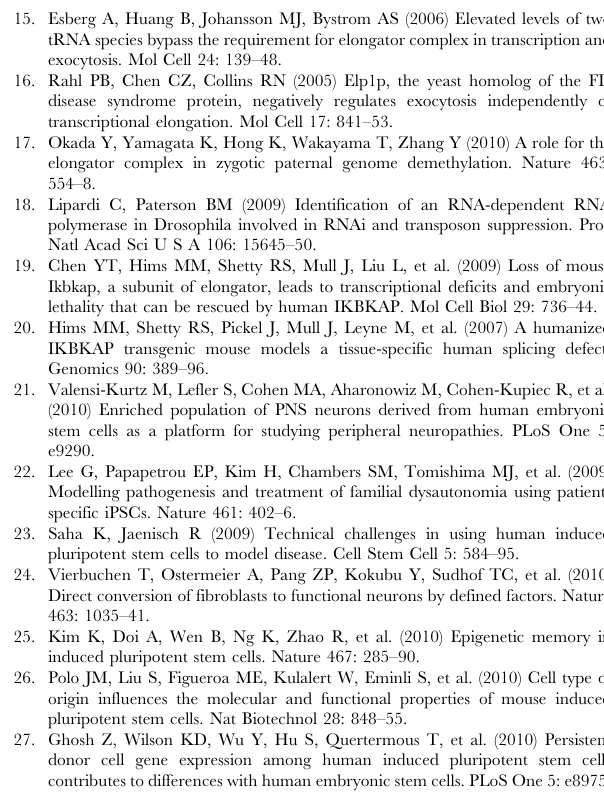
Figure S2 IKBKAP exon 36 inclusion increases after cycloheximide treatment. NMD pathway was blocked by the translation inhibitor cycloheximide and results in an elevated expression of exon 36-including transcripts in 2 FD OE-MSC cultures (FD3 and FD4) as determined by absolute RT-qPCR. (* P , 0.05).